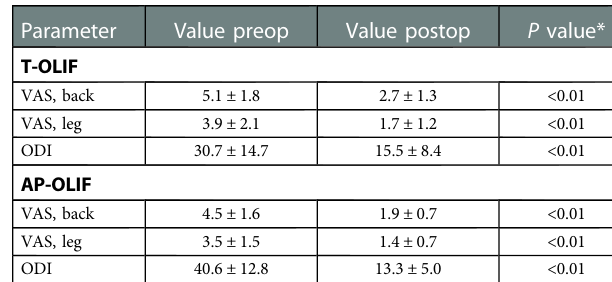
TABLE 3 Clinical